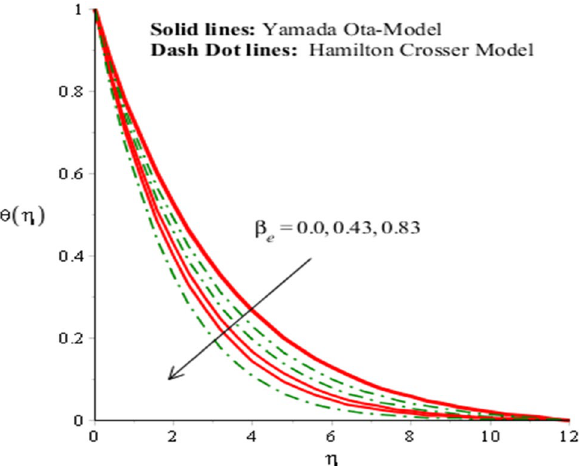
Figure 8. Analysis of heat energy field in against β e when ∅ 1 = 0.002, ∅ 2 = 0.0075, (cid:31) = 0.3, α = 2.0,